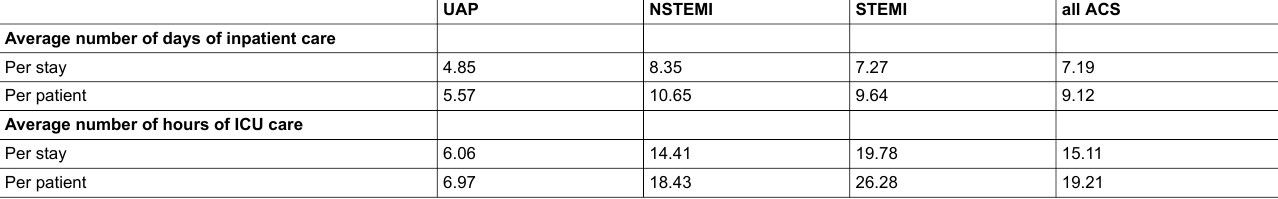
Table 4: Outpatient resource use after hospital discharge.